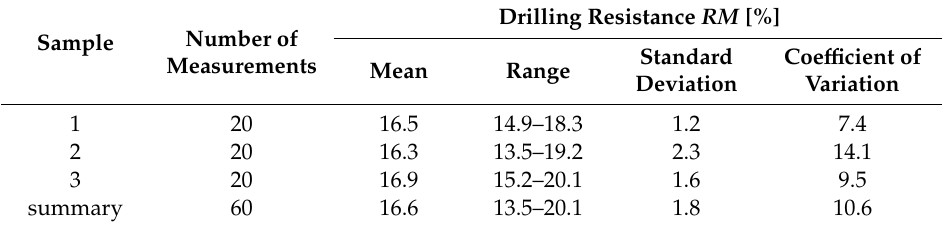
Table 7. Mean feed force test results.